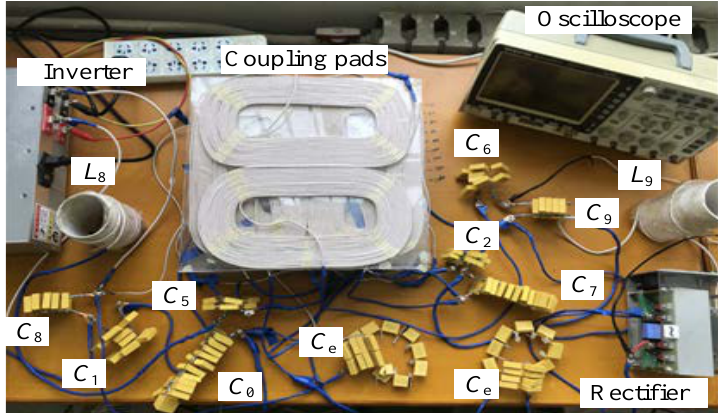
Figure 10. Experimental set-up of the proposed hybrid IPT system.